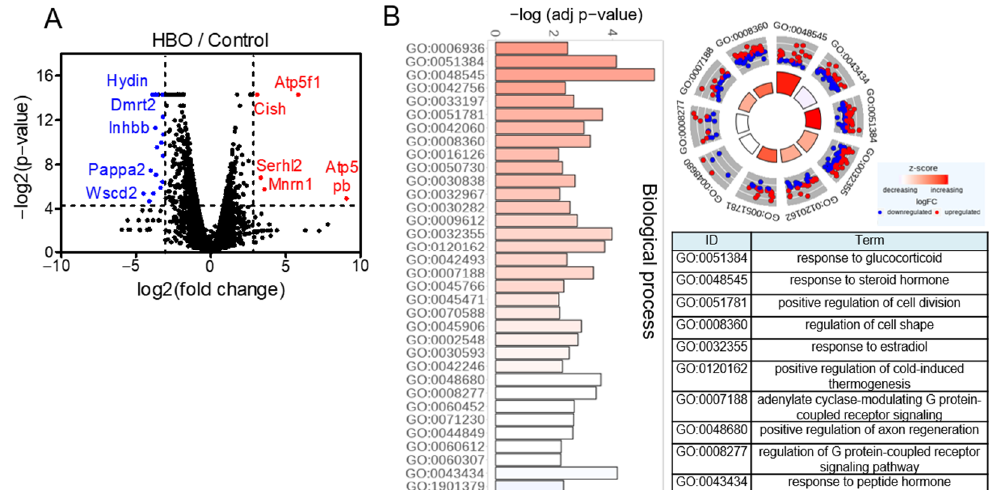
Figure 2. RNA-seq and Western blot results of brown adipose tissues for the 7 day HBO condition. ( A ) RNA sequencing of BAT after HBO. Volcano plot of differentially expressed genes identified between control and hyperbaric oxygen therapy. Blue dots indicate downregulated, and red dots denote upregulated gene expression with significance (cut-off: p < 0.05, Fold change >3). ( B ) Gene Ontology (GO) analysis of biological processes between control and HBO conditions based on RNA sequencing.